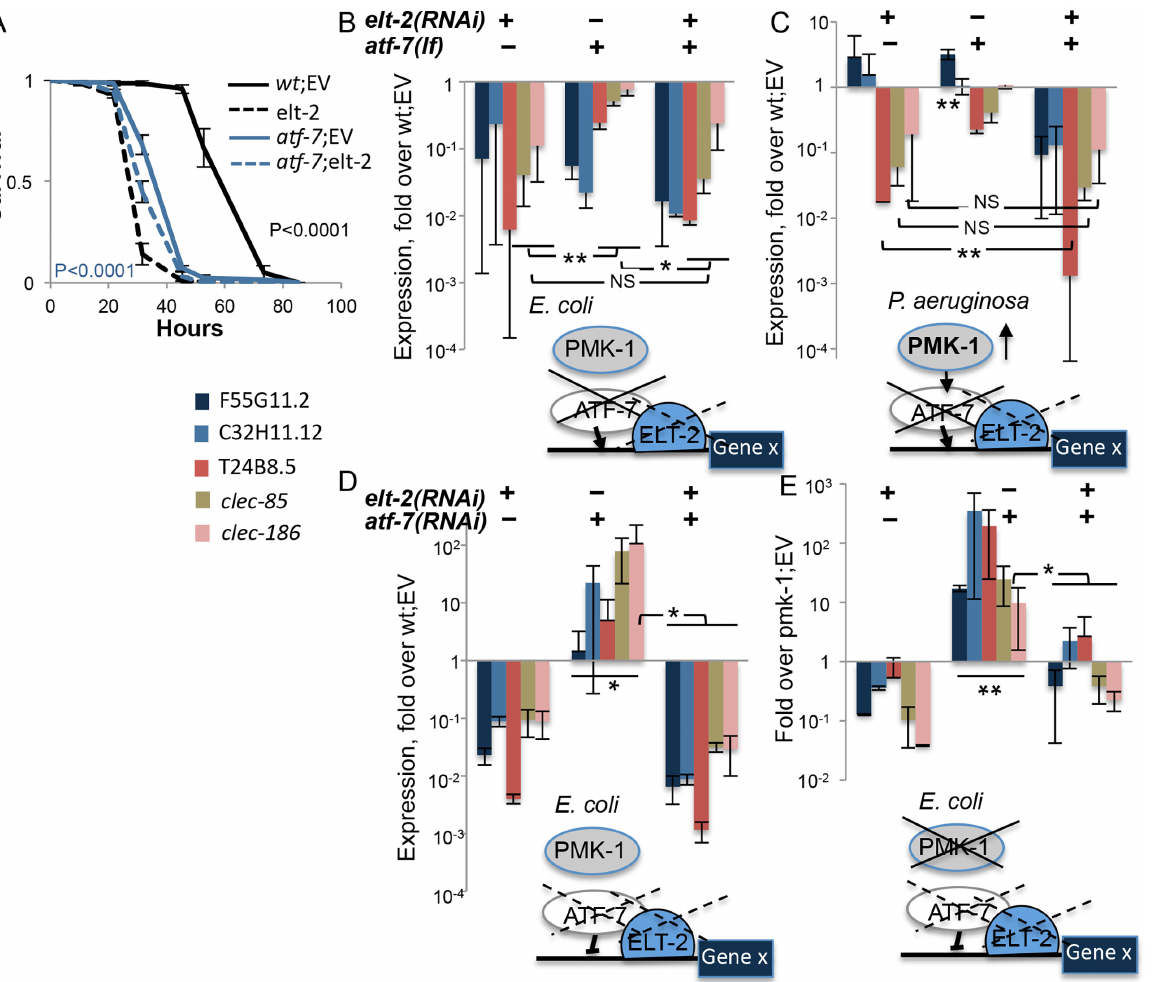
Fig 3. elt-2 is essential for atf-7 -dependent immune gene regulation. A . Survival curves for wildtype and atf-7(qd22qd130) animals fed with designated RNAi ’ s during development followed by infection. Averages ± SDs for three plates (N = 129 – 140 per group) in a representative experiment of several others with similar results. B-E , Gene expression (log scale) in wildtype, pmk-1(km25) , and atf-7(qd22qd130) animals, fed with designated RNAi ’ s during development. Models depict for each panel the mode of disruption, or status, of examined factors (solid-line crosses, loss-of-function mutants; dashed-line crosses, knock-down), placing ELT-2 tentatively at the proximal promoter of immune genes (Gene X) putatively regulated by PMK-1 and ATF-7; atf-7 is depicted as an activator (arrow) or repressor (blunt-ended arrow), based on disruption effects on gene expression. RNA levels were measured in L4/YA worms. Each panel presents averages and SDs for two independent experiments. Asterisks mark inter-group significance with * p < 0.05, ** p < 0.01, and NS, non-significant (paired t-test) for all genes in the group or in underlined subset.